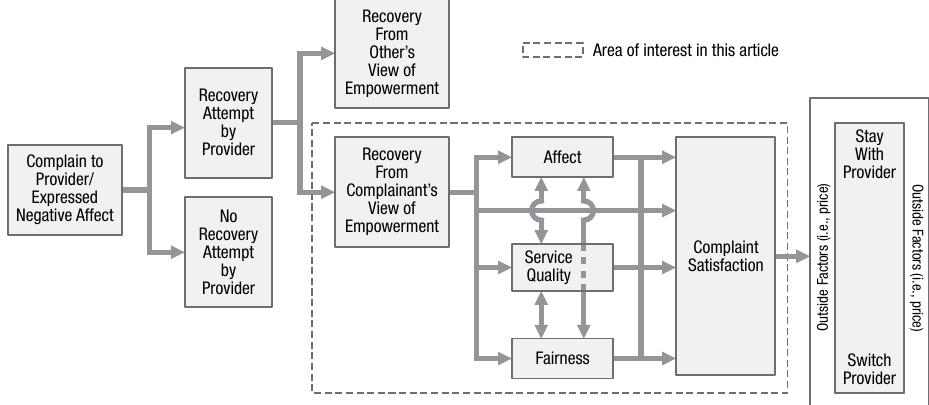
Fig. 1. The service recovery